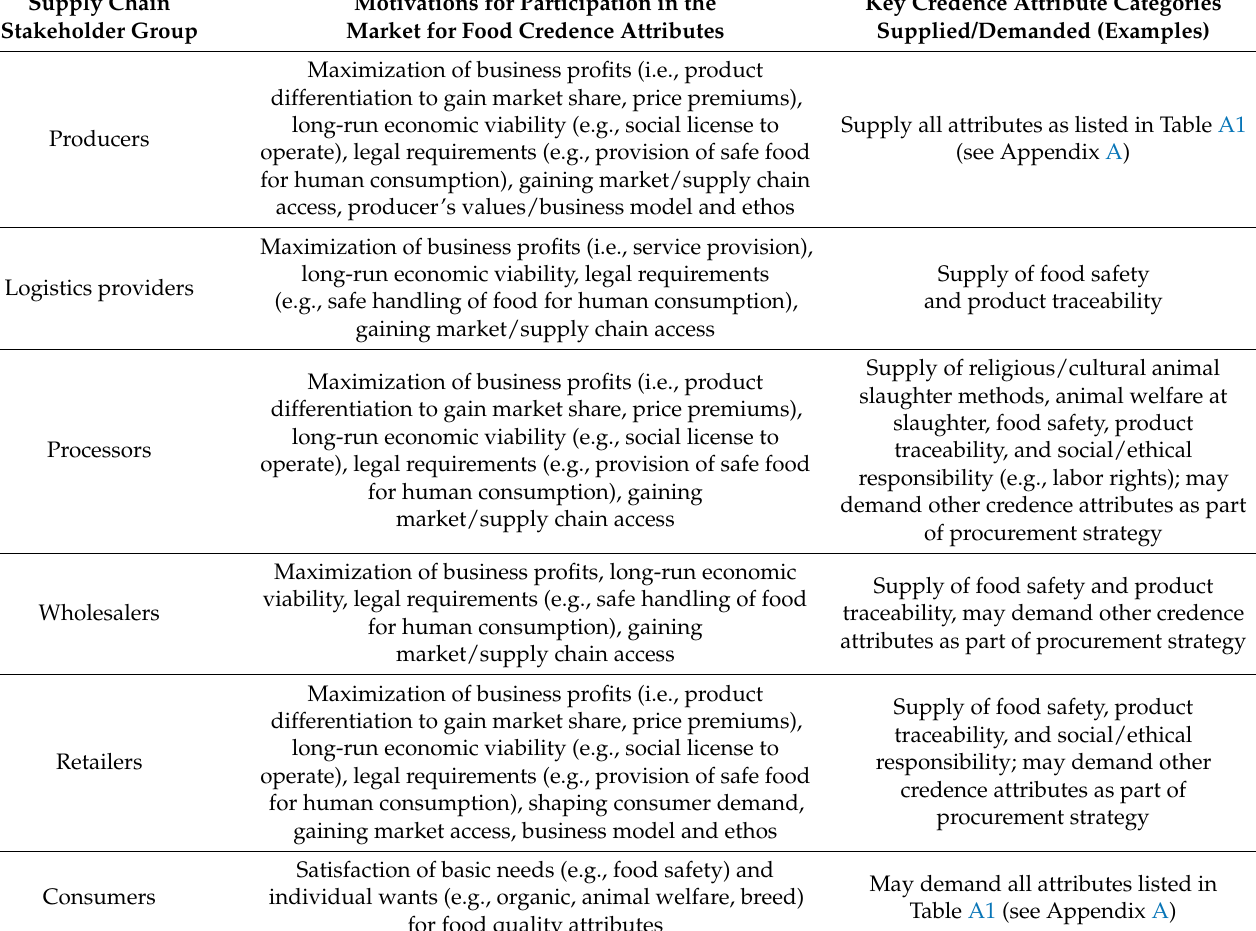
Table 1. Motives for stakeholders’ participation in the market for food credence